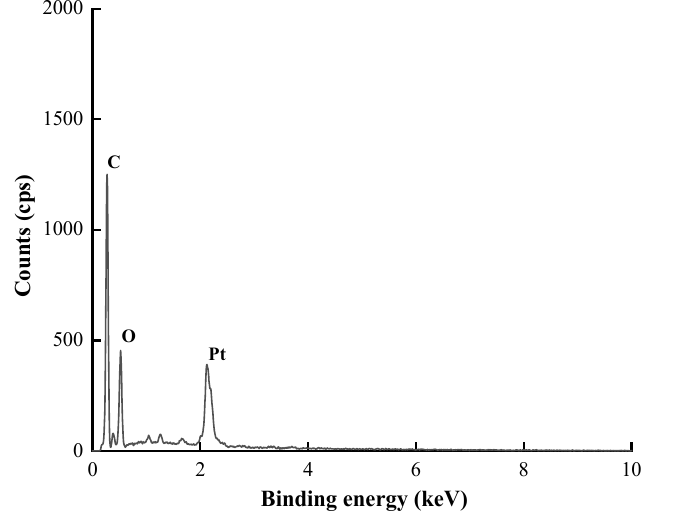
Figure 7. EDS spectrum of PtNPs. Table 1. EDS data of PtNPs.